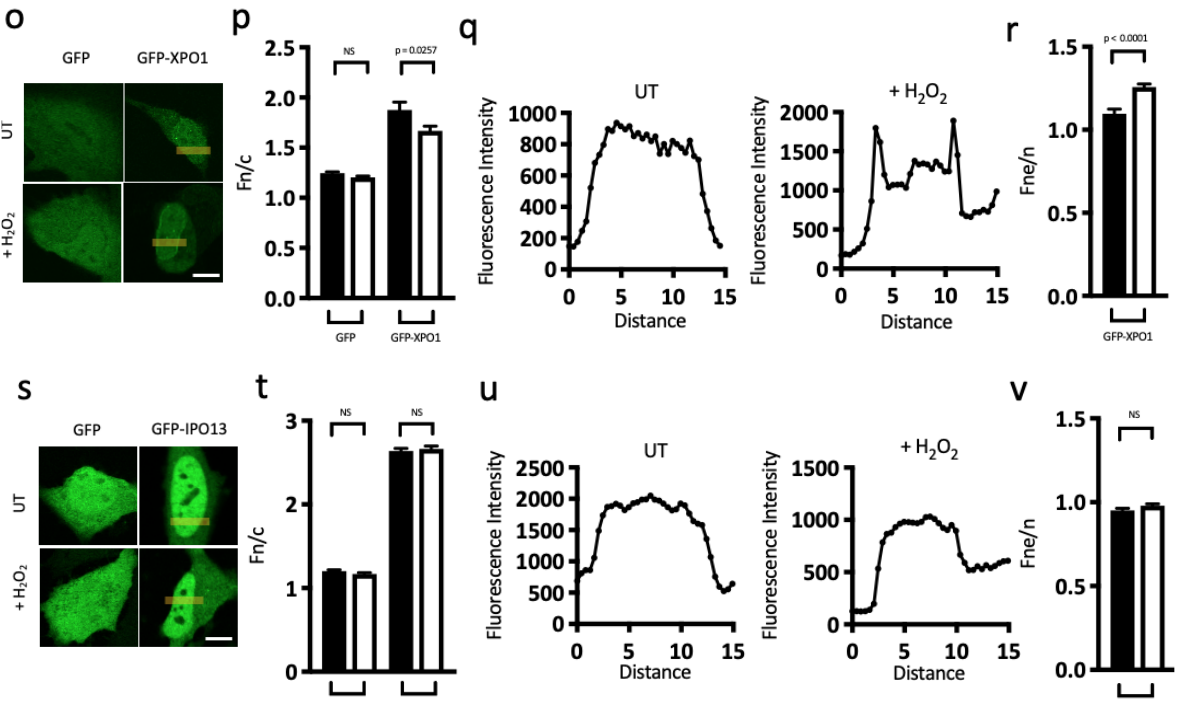
Figure 5. Stress disrupts the localisation of nuclear transport machinery components but not IPO13. ( a , b ) HeLa cells were treated ± 125μM H 2 O 2 for 1 h or ± 43 °C for 1 h prior to staining with mouse- anti-Ran (BD Biosciences) and counter- staining with DAPI, Scale bar = 10 μM. Quantitative analysis of Ran localisation ( b ) was carried out using the ImageJ software on images, such as those in ( a ), to determine the nuclear-to-cytoplasmic-fluorescence ratio (Fn/c) of Ran, as described in Materials and Methods. Values represent the mean + SEM (n > 50 cells) from a single typical experiment from a series of 2 similar experiments. ( c , d ) Typical CLSM images of HeLa cells, 16 h post-transfection to express GFP or GFP- IMPα ( c ) a nd treated ± 125 μM H 2 O 2 for 1 h prior to imaging live, Scale bar = 10 μM . Quantitative analysis of GFP or GFP- IMPα ( d ) was carried out as in ( b ). Values represent the mean ± SEM (n > 30 cells) from a single typical experiment from a series of 3 similar experiments. ( e , f ) Typical line fluorescence intensity histograms of GFP- IMPα ( e ) were measured across the nu- clear envelope as indicated by the yellow line on the corresponding cell images ( c ). ( f ) Quantitative analysis of GFP- IMPα was carried out using the ImageJ software on images, such as those in ( c ), to determine the nuclear-envelope-to-nuclear ratio (Fne/n), as described in Materials and Methods. Values represent the mean ± SEM (n > 30 cells) from a single typical experiment from a series of 3 similar experiments. ( g , h ) Typical CLSM images of HeLa cells, 16 h post-transfection to express GFP or GFP- IPOβ1 ( c) and treated ± 125 μM H 2 O 2 for 1 h prior to imaging live, Scale bar = 10 μM . Quan- titative analysis of GFP or GFP- IPOβ1 ( d ) was carried out as in ( b ). Values represent the mean + SEM (n > 30 cells) from a single typical experiment from a series of 3 similar experiments. ( i , j ) Typ- ical line fluorescence intensity histograms of GFP-I POβ1 ( i ) were measured across the nuclear en- velope, as indicated by the yellow line on the corresponding cell images ( g ). ( j ) Quantitative analysis of GFP- IPOβ1 was carried out as in ( f) . Values represent the mean ± SEM (n > 30 cells) from a single typical experiment from a series of 3 similar experiments. ( k , l ) Typical CLSM images of HeLa cells, 16 h post-transfection to express GFP or GFP-IPO7 ( k ) and treated ± 125 μM H 2 O 2 for 1 h prior to imaging live, Scale bar = 10 μM . Quantitative analysis of GFP or GFP-IPO7 ( l ) was carried out as in ( b) . Values represent the mean ± SEM (n >30 cells) from a single typical experiment from a series of 3 similar experiments. ( m , n ) Typical line fluorescence intensity histograms of GFP-IPO7 ( m ) were measured across the nuclear envelope, as indicated by the yellow line on the corresponding cell images ( k ). ( n ) Quantitative analysis of GFP-IPO7 was carried out as in ( f) . Values represent the mean ± SEM (n > 30 cells) from a single typical experiment from a series of 3 similar experiments. ( o , p ) Typical CLSM images of HeLa cells, 16 h post-transfection to express GFP or GFP-XPO1 ( o ) and treated ± 125 μM H 2 O 2 for 1 h prior to imaging live, Scale bar = 10 μM . Quantitative analysis of